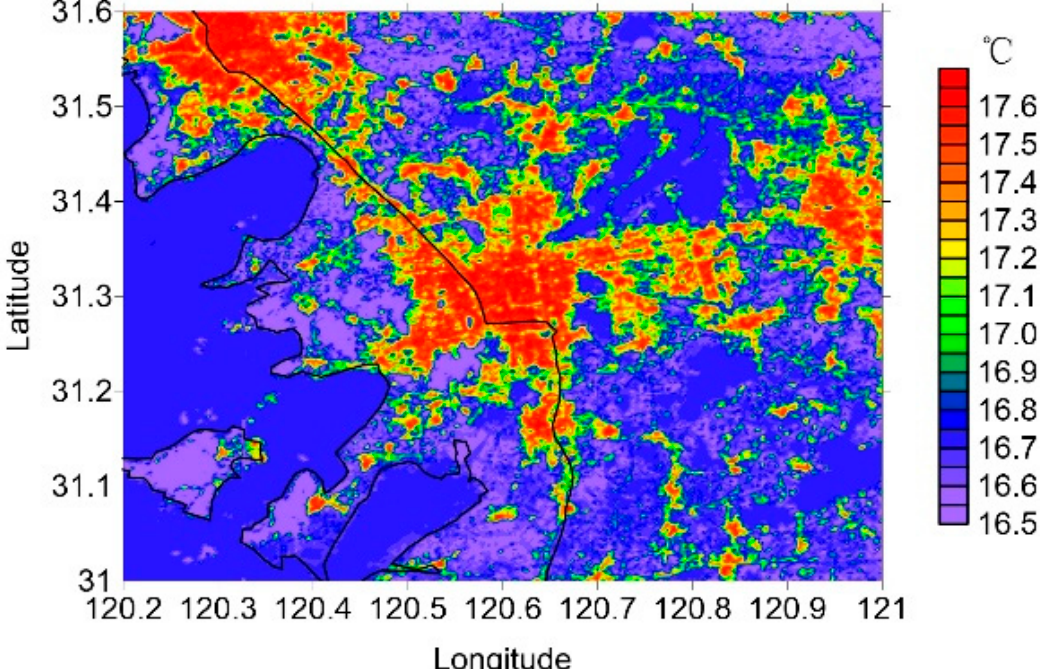
Figure 4. The spatial distribution of the annual average near-surface temperature.